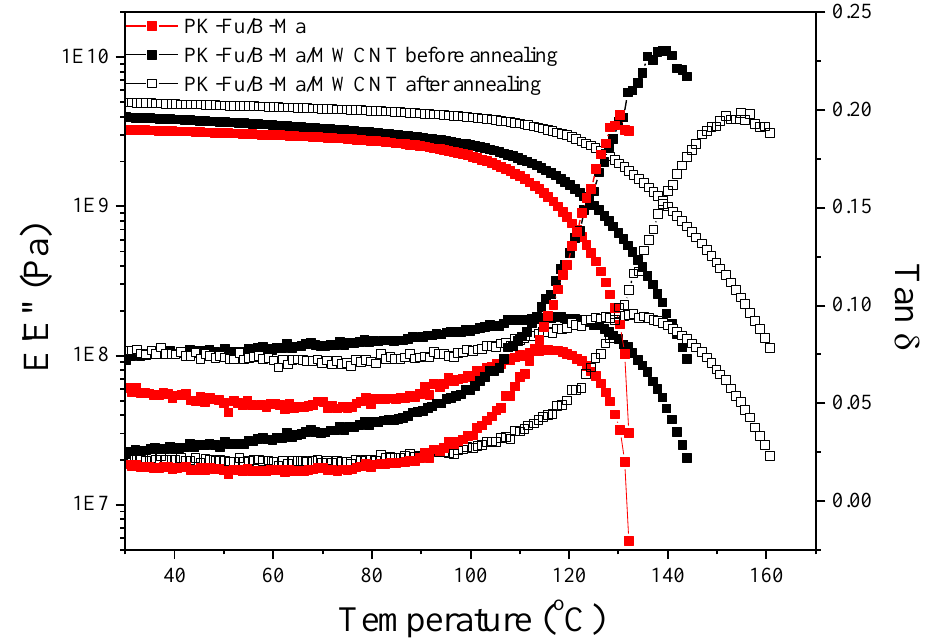
were also determined after compression a grinded sample at 150 ◦ C and 40 bar for 30 min. This process was supposed to favour r-DA mechanism and the consequent de-crosslinking of the thermoset systems as high performance conductive and recyclable thermoplastics. DMTA analysis performed on clear enhancements of softening point (tan( δ ) peak), loss and elastic moduli with respect to the neat crosslinked system (Figure 7).